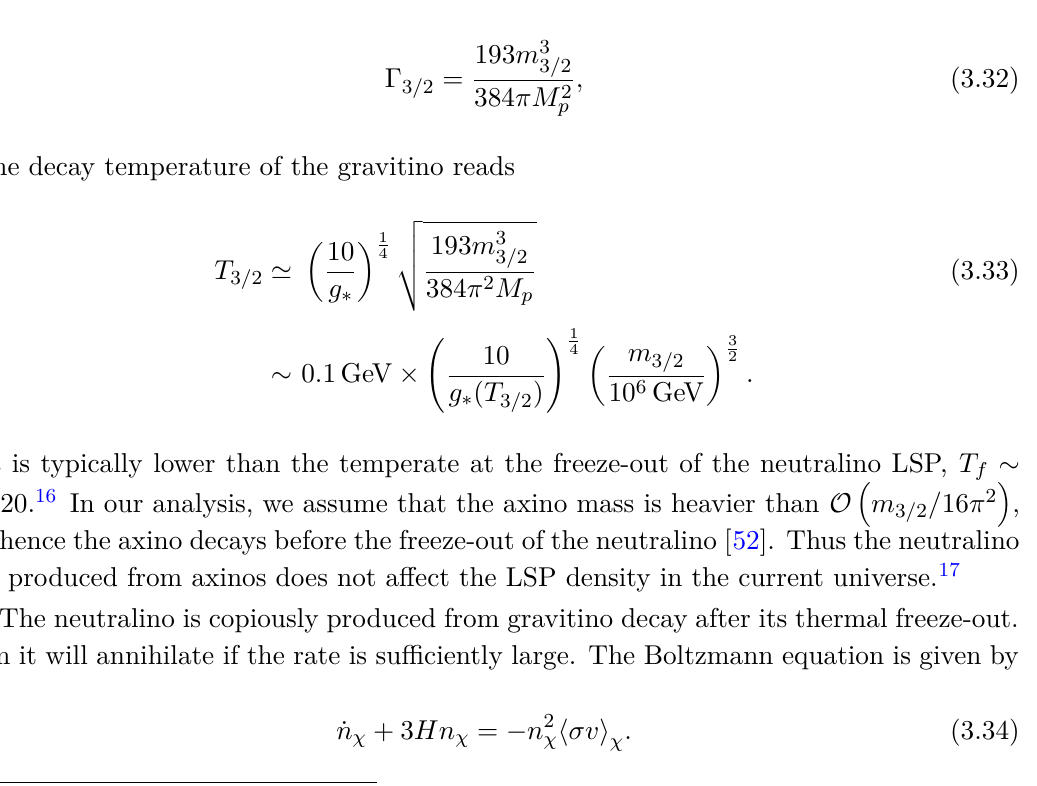
= 10 6 GeV ( n = 8 , m P